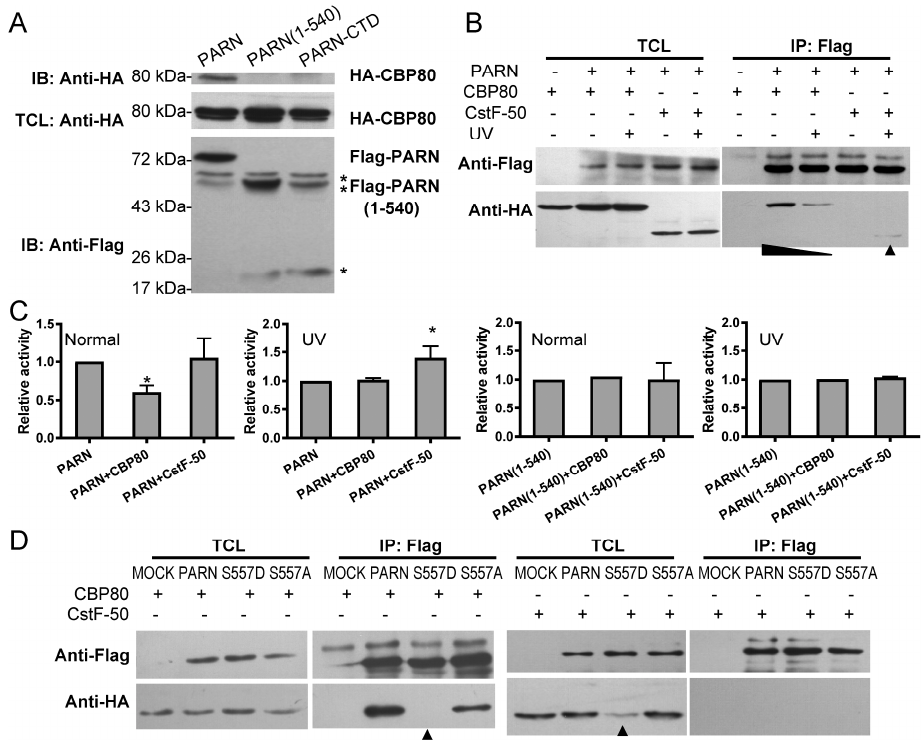
Figure 5. The CTD contributes to the interactions of PARN with CBP80 and CstF-50. ( A ) Co-IP experiments using the anti-Flag antibody to detect the interaction between HA-CBP80 and Flag-PARN. IB represents immunoblot using anti-Flag antibody to detect Flag-PARN and anti-HA antibody to detect the HA-CBP80. TCL is the total cell lysates of the HEK-293T cells. The asterisks indicate the Ig heavy and light chains. The band of PARN(1–540) overlapped with that of the Ig heavy chain. ( B ) Co-IP experiments to identify the interactions between Flag-PARN and HA-CBP80/HA-CstF50 in untreated and UV-treated HEK-293T cells. ( C ) Effect of CBP80 or CstF-50 on the deadenylase activity of PARN in TCL of the HEK-293T cells ( n = 3). The deadenylation activity of PARN was determined by the SEC method. The amounts of PARN expression level were detected by the western-blot and adjusted to the same level for all testing groups. ( D ) Effect of S557D mutation on the binding of Flag-PARN with HA-CBP80 and HA-CstF-50. MOCK is the control group of cells co-transfected with HA-CBP80/HA-CstF-50 and the empty vector. * p < 0.05.